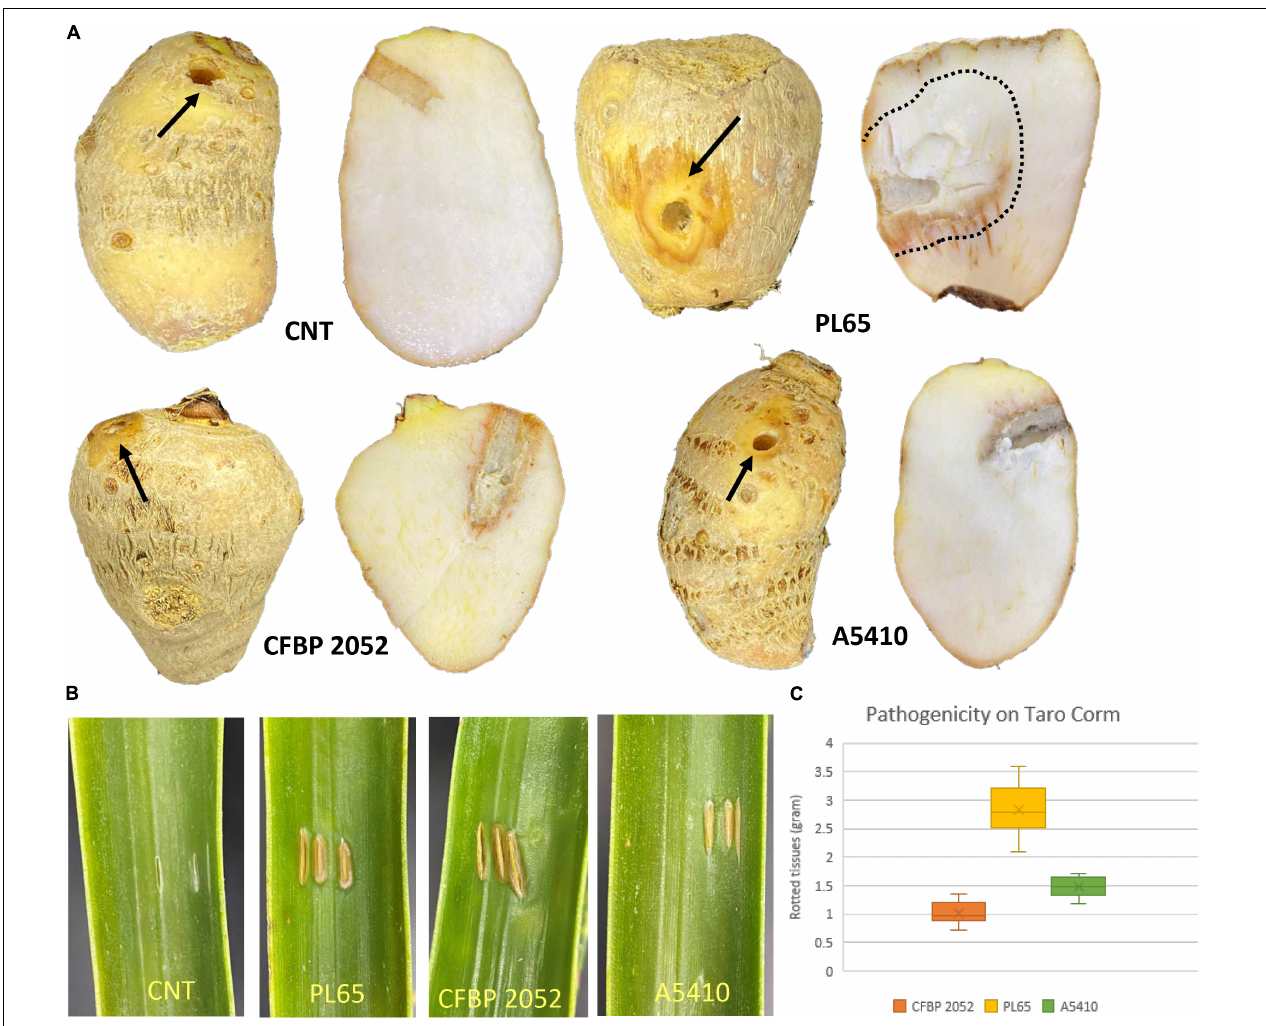
FIGURE 12 | Pathogenicity of D. zeae strains on taro corm and pineapple leaf. (A) Infected and control taro corm (CNT) after incubation. Decayed tissue is indicated by black arrows and black dotted lines on the taro corm. (B) Infected and control leaves (CNT) 72 h after inoculation. (C) Percentage of macerated tissue from taro